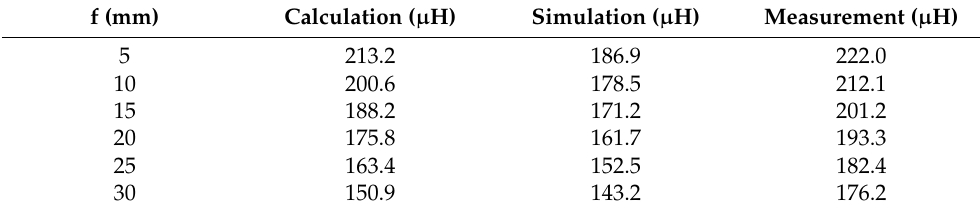
Table 3. Transformer leakage inductance with changes in parameter